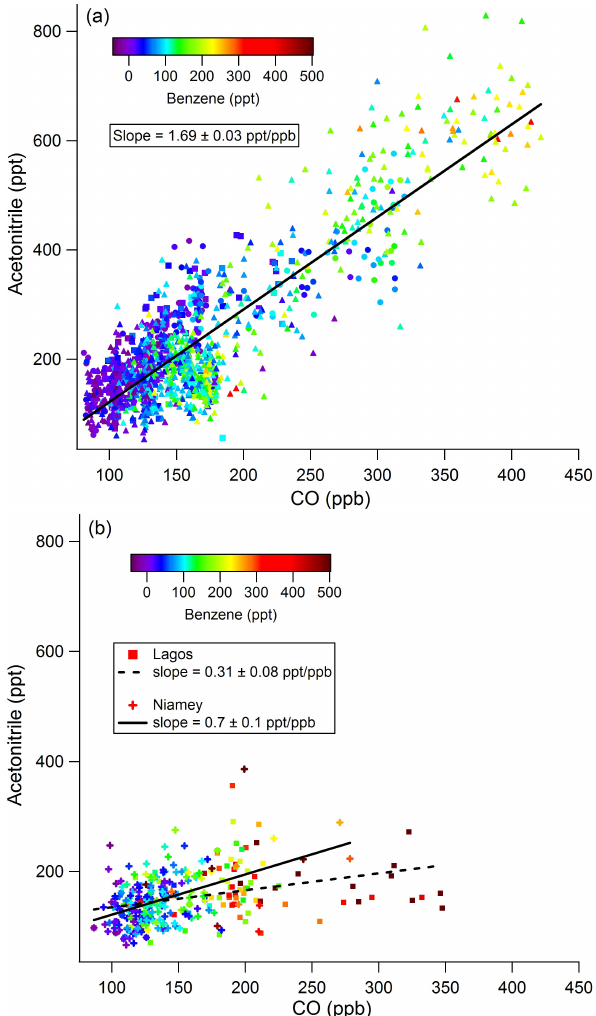
Fig. 7. Scatter plots of acetonitrile against CO coloured by benzene for (a) all the data from Flight B228 ( • ), B229 ( (cid:4) ) and B231 ( N ) except the Lagos measurements from B229, and (b) Lagos measure- ments from B229 and Niamey measurements from several